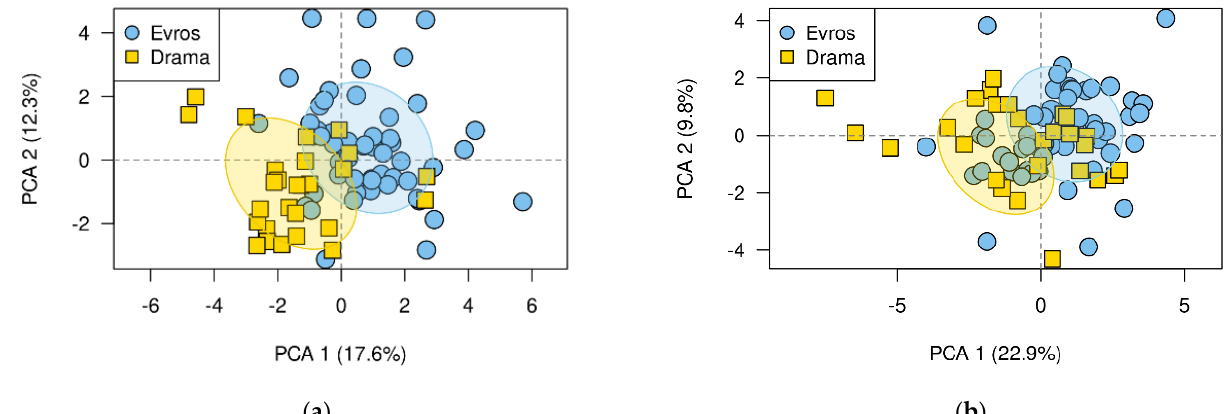
Figure 3. PCA plot of individuals, under ( a ) non-frequent and ( b ) frequent watering.